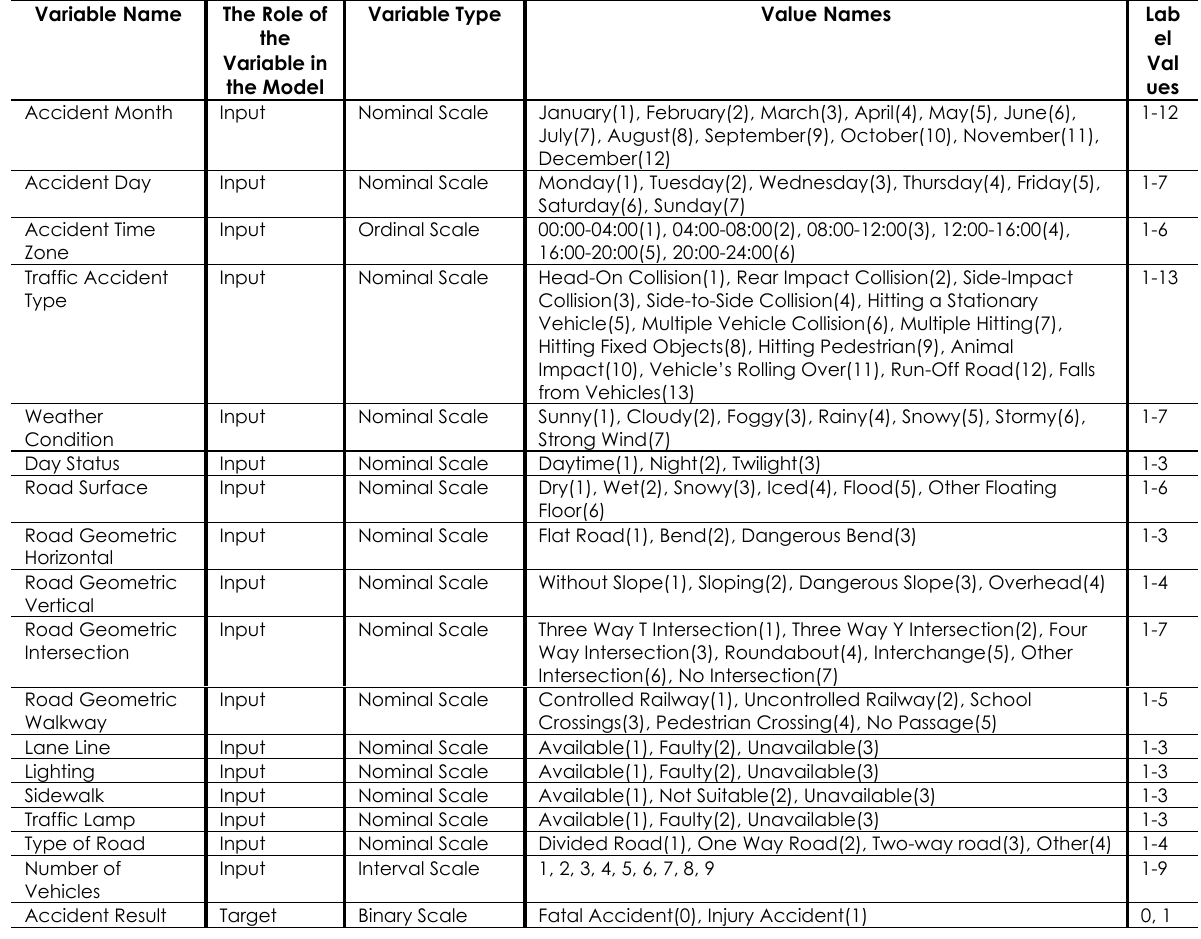
Table 2. Table of variables used in the